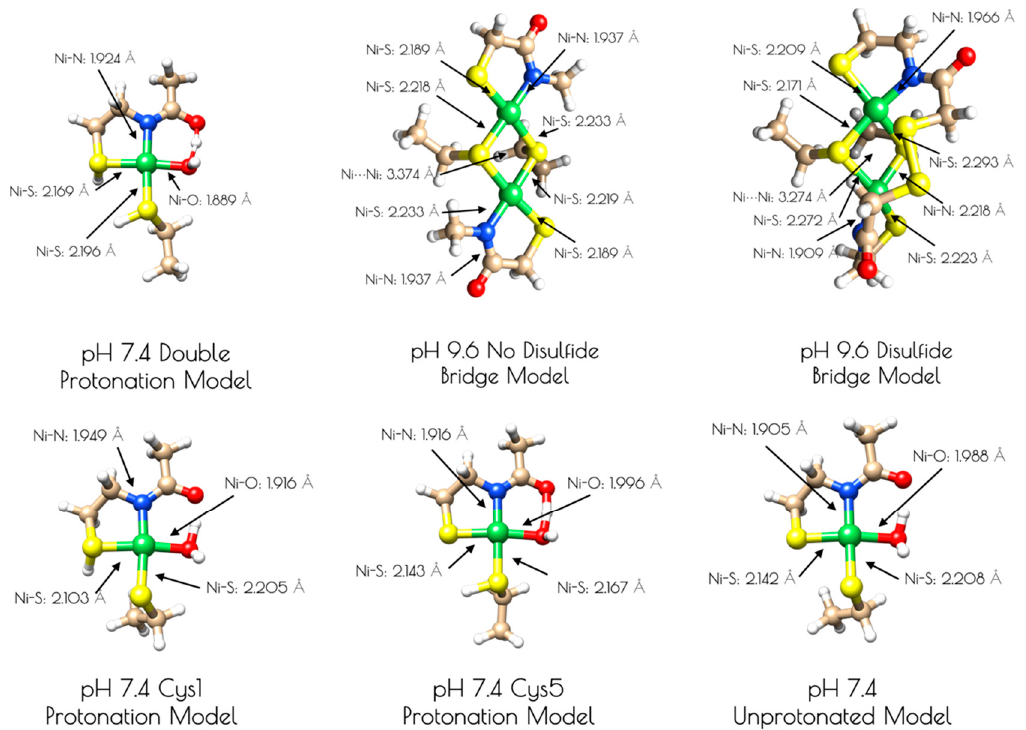
Figure 5. Computationally derived nickel site models of {Ni 2II (SOD mds )}. Metric parameters are provided next to the Ni-ligand bonds.